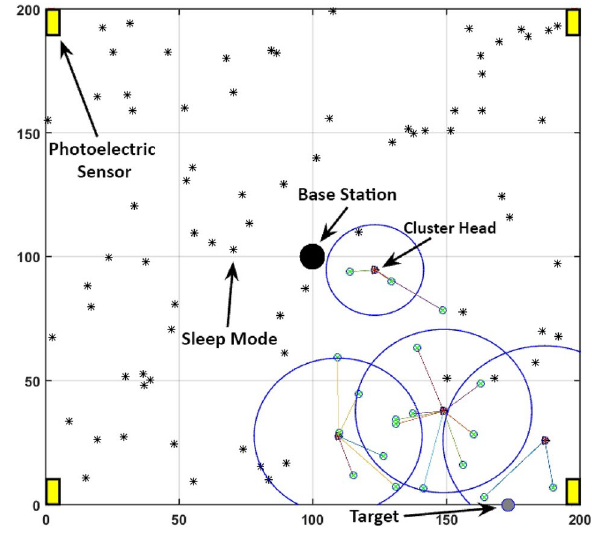
Fig. 3 An example of WSN used in the second protocol